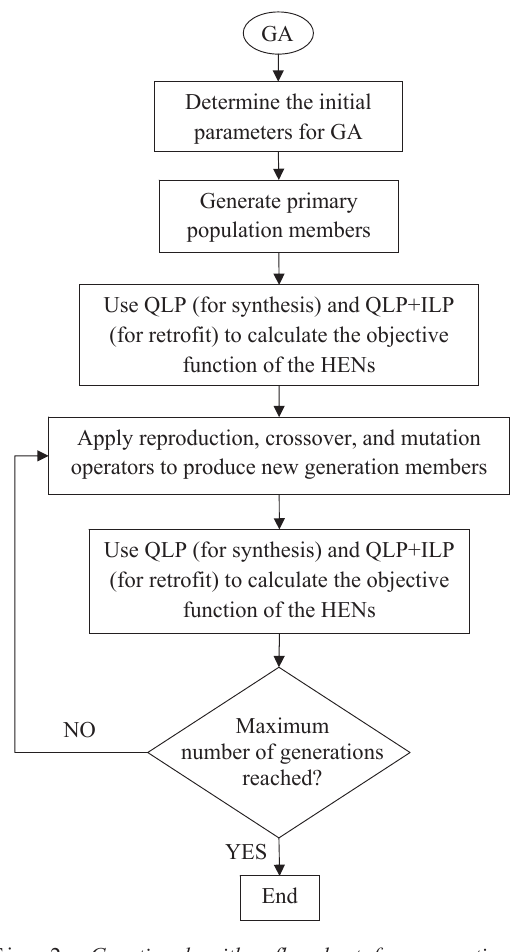
Fig. 2 – Genetic algorithm flowchart for generating HEN